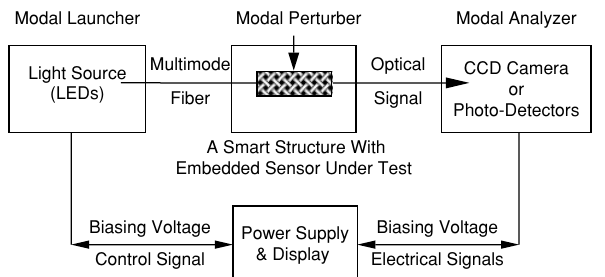
Figure 1 The general block diagram of the developed characterization method.